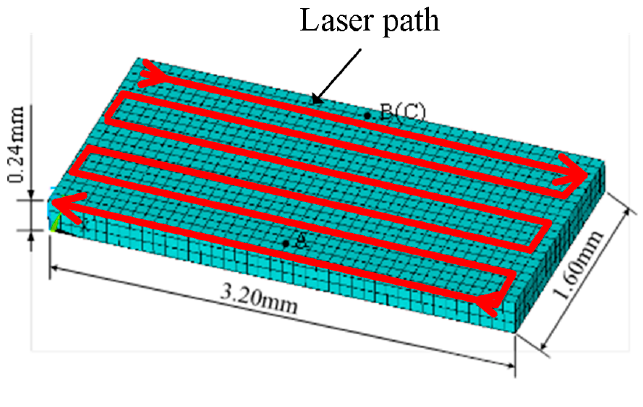
Figure 7. Meshed model. Table 7. Thermophysical and laser properties in FE model.